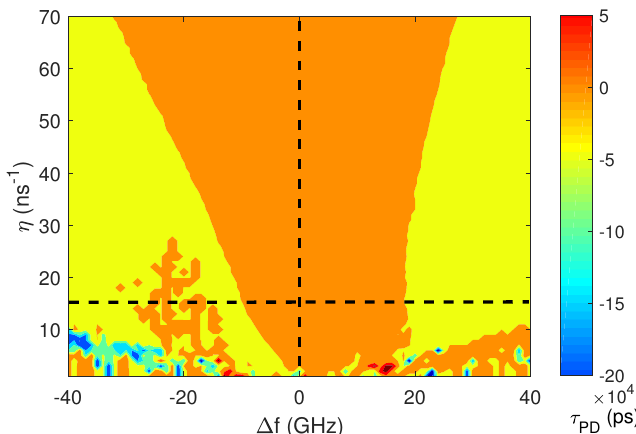
Figure 5. Intra-cavity propagation delay τ PD map in the injection parameters (frequency detuning ∆ f , injection rate η ) plane for keeping κ = 9 ns − 1 , τ ext = 10 ns, and τ f = 0.